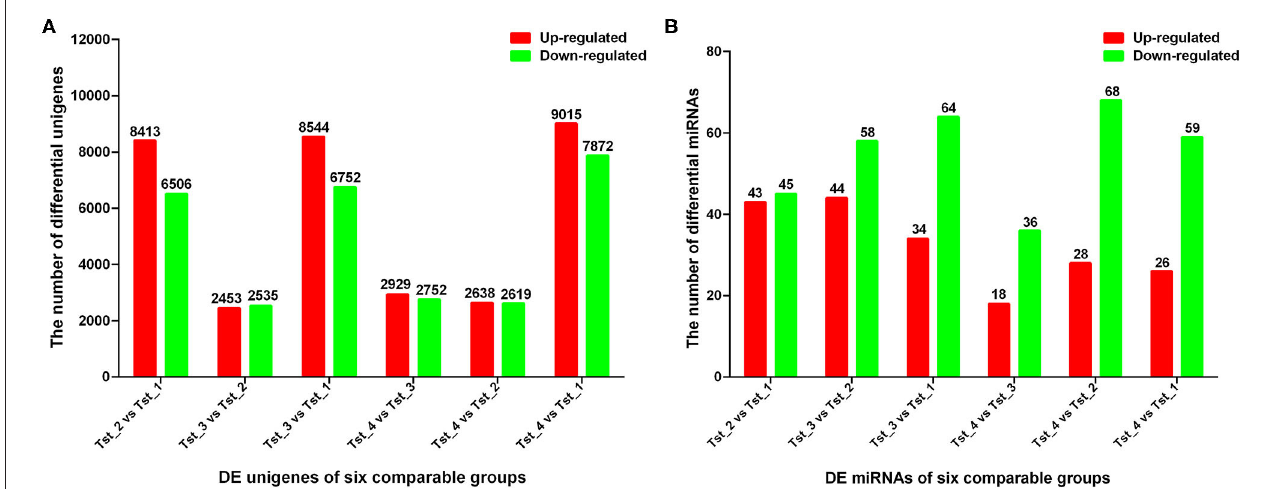
FIGURE 1 | Statistics for DE unigenes and miRNAs in each comparable group. (A) q value < 0.005 and | log2 ( fold change ) | > 1 were used as thresholds of significance for DE unigenes. (B) q value < 0.01 and | log 2 ( fold change ) | > 1 were used as thresholds of significance for DE miRNAs.